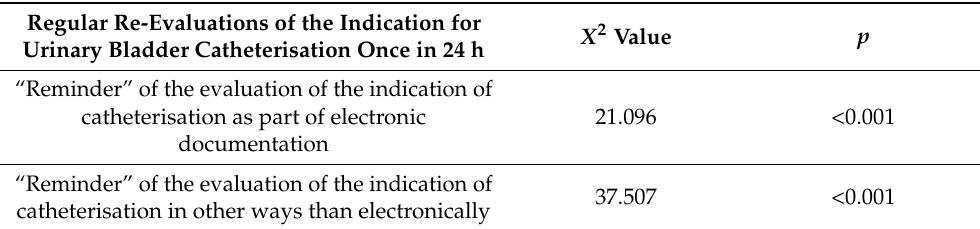
Table 7. Relationship of the variables “re-evaluation of indication for catheterisation and the function of reminders for re-evaluation . . .